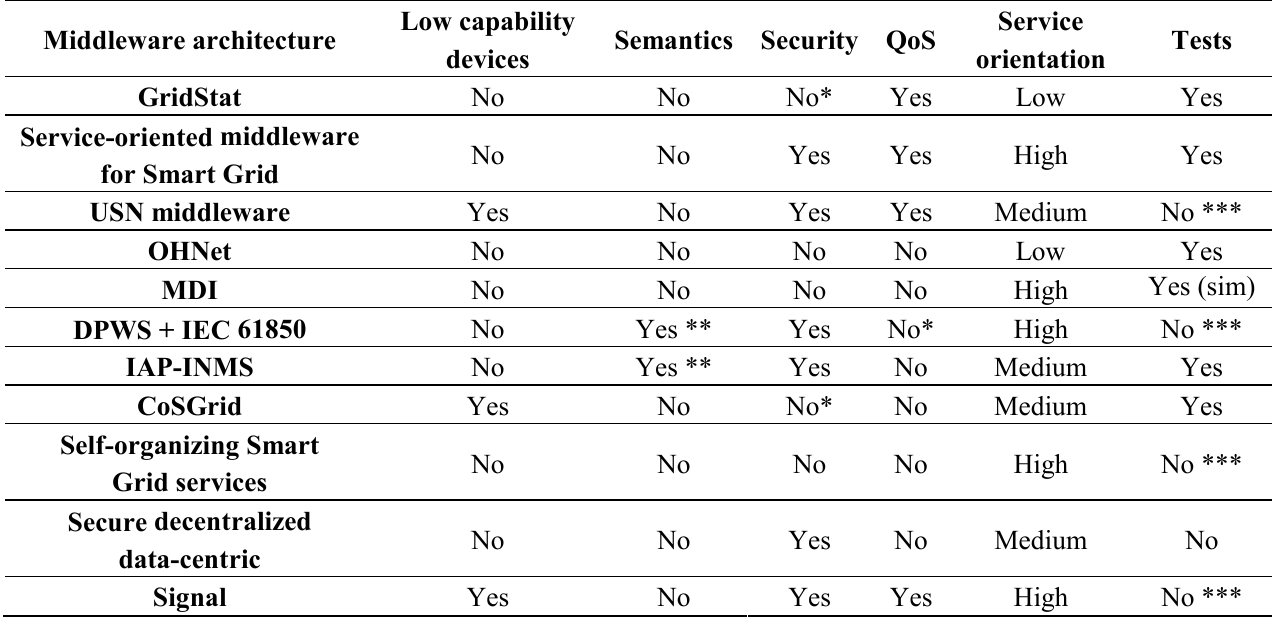
Table 12. Main features of the surveyed middleware